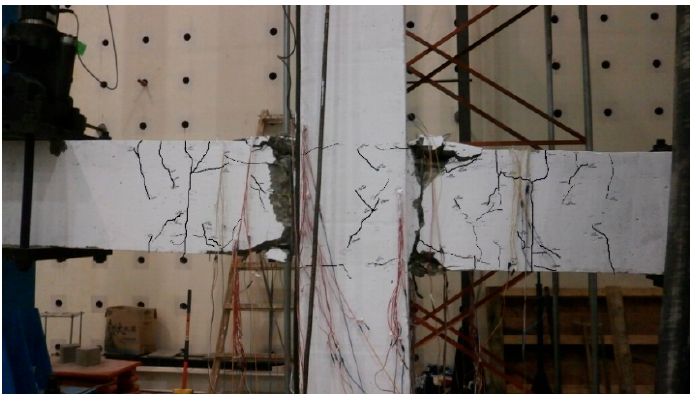
Figure 12. Final damage of the PPCJ1 joint.